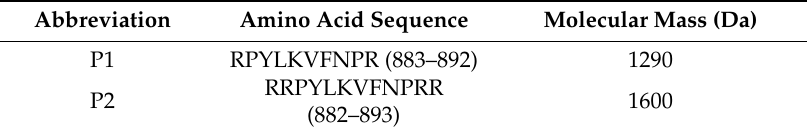
Table 2. Amino acid sequences of the peptides used in this